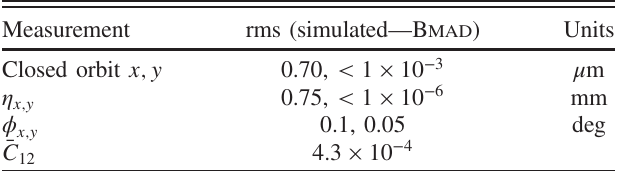
TABLE IV. rms difference between simulated measurements and B MAD -calculated values, neglecting any BPM measurement